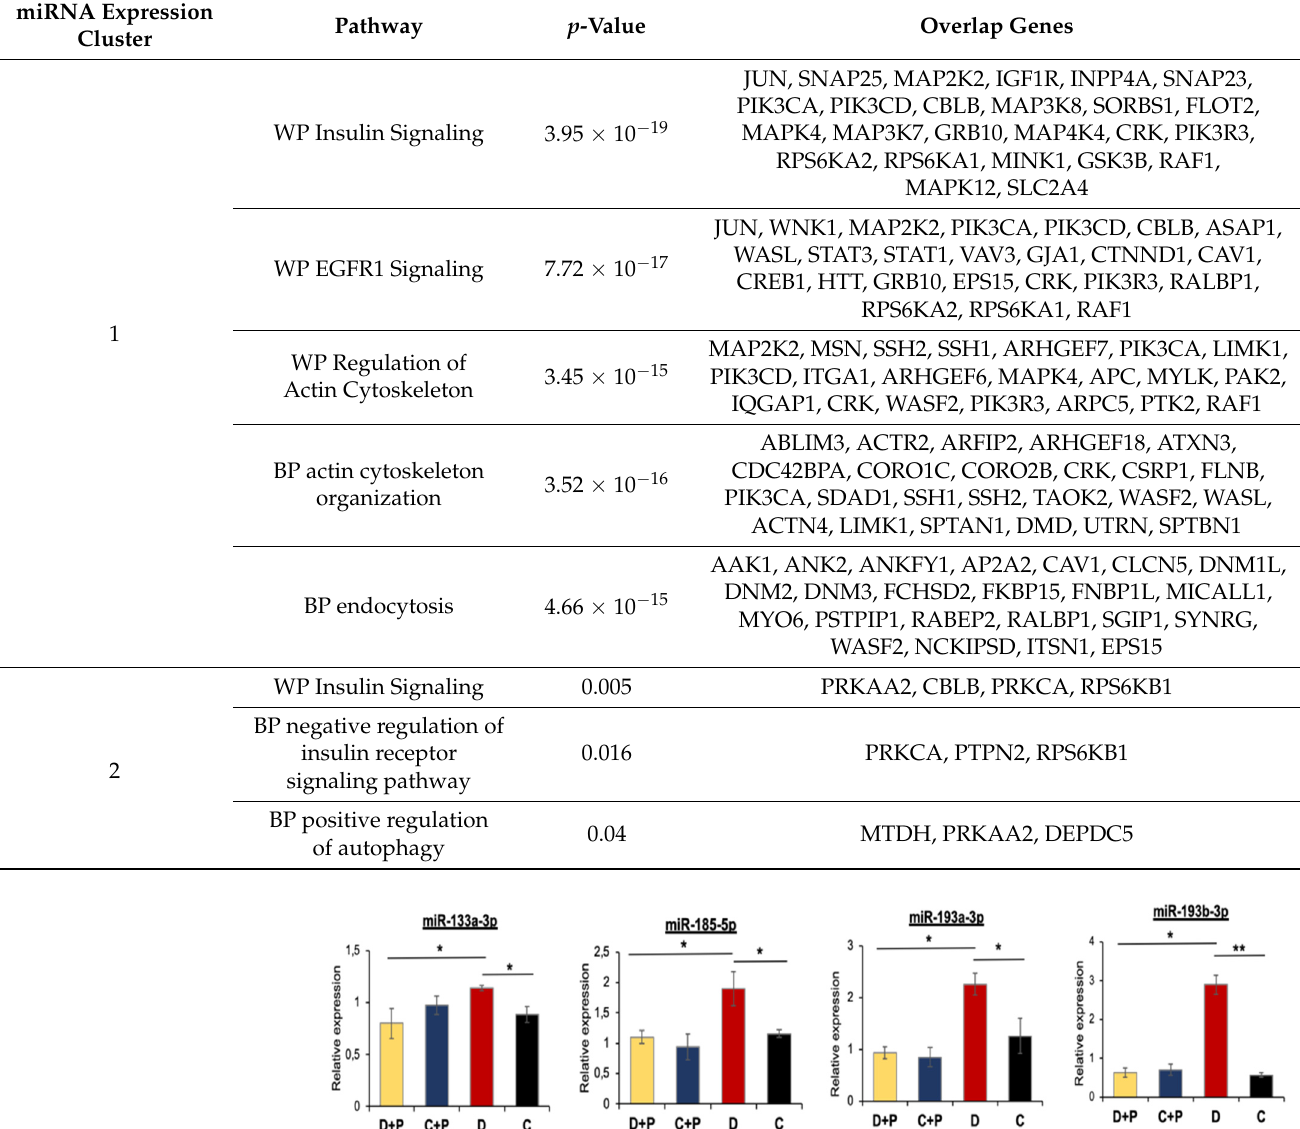
Table 4. MiRNA target enrichment analysis. Wiki pathways (WP) and biological processes (BP) enriched among the miRNA targets.